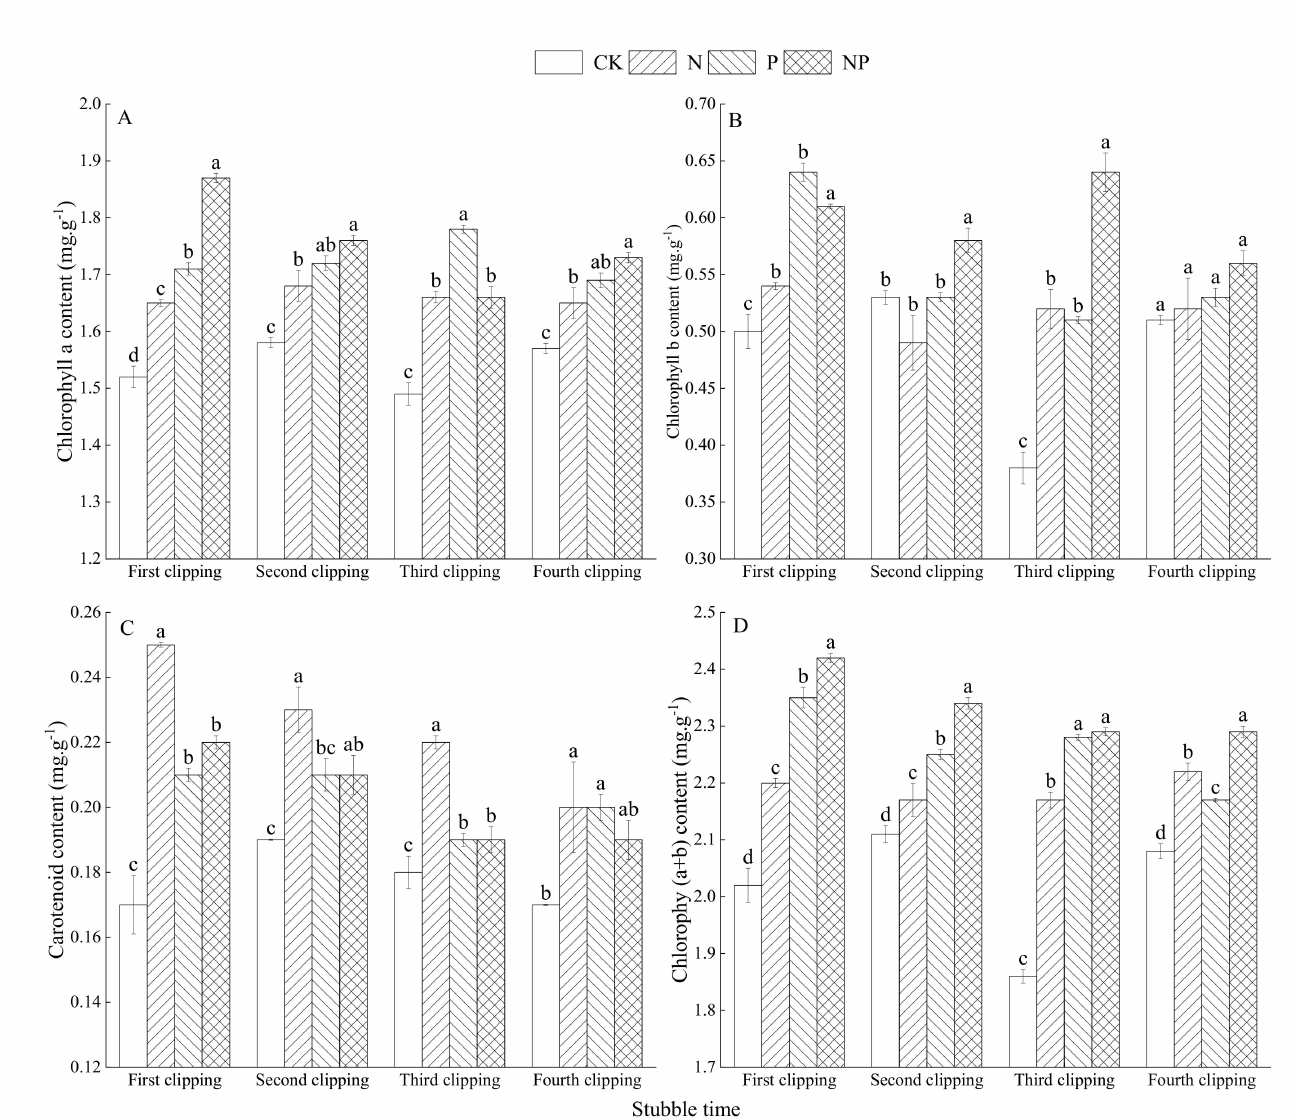
Figure 3. Effect of nitrogen and phosphorus on chlorophyll and carotenoid contents of ( A ) Chloro- phyll a content, ( B ) chlorophyll b content, ( C ) carotenoid content and ( D ) chlorophyll (a + b) content of alfalfa leaves. Different letters above column indicate significant difference among treatments with different ( p <